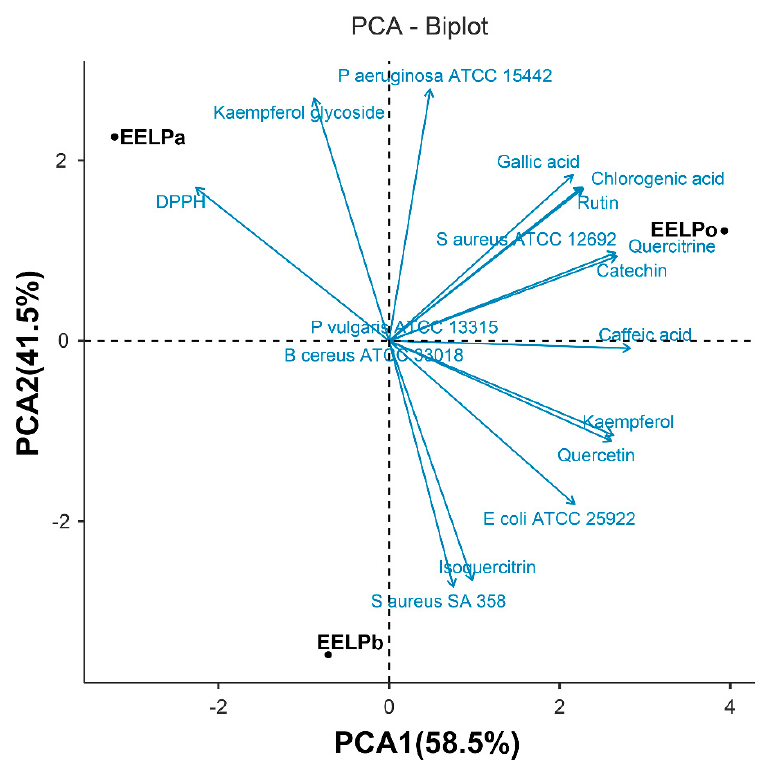
Figure 6. Principal component analysis (PCA) of the influence of flavonoids and phenolic acid phytoconstituents of Plectranthus species (Lamiaceae) under antibacterial and antioxidant activity.